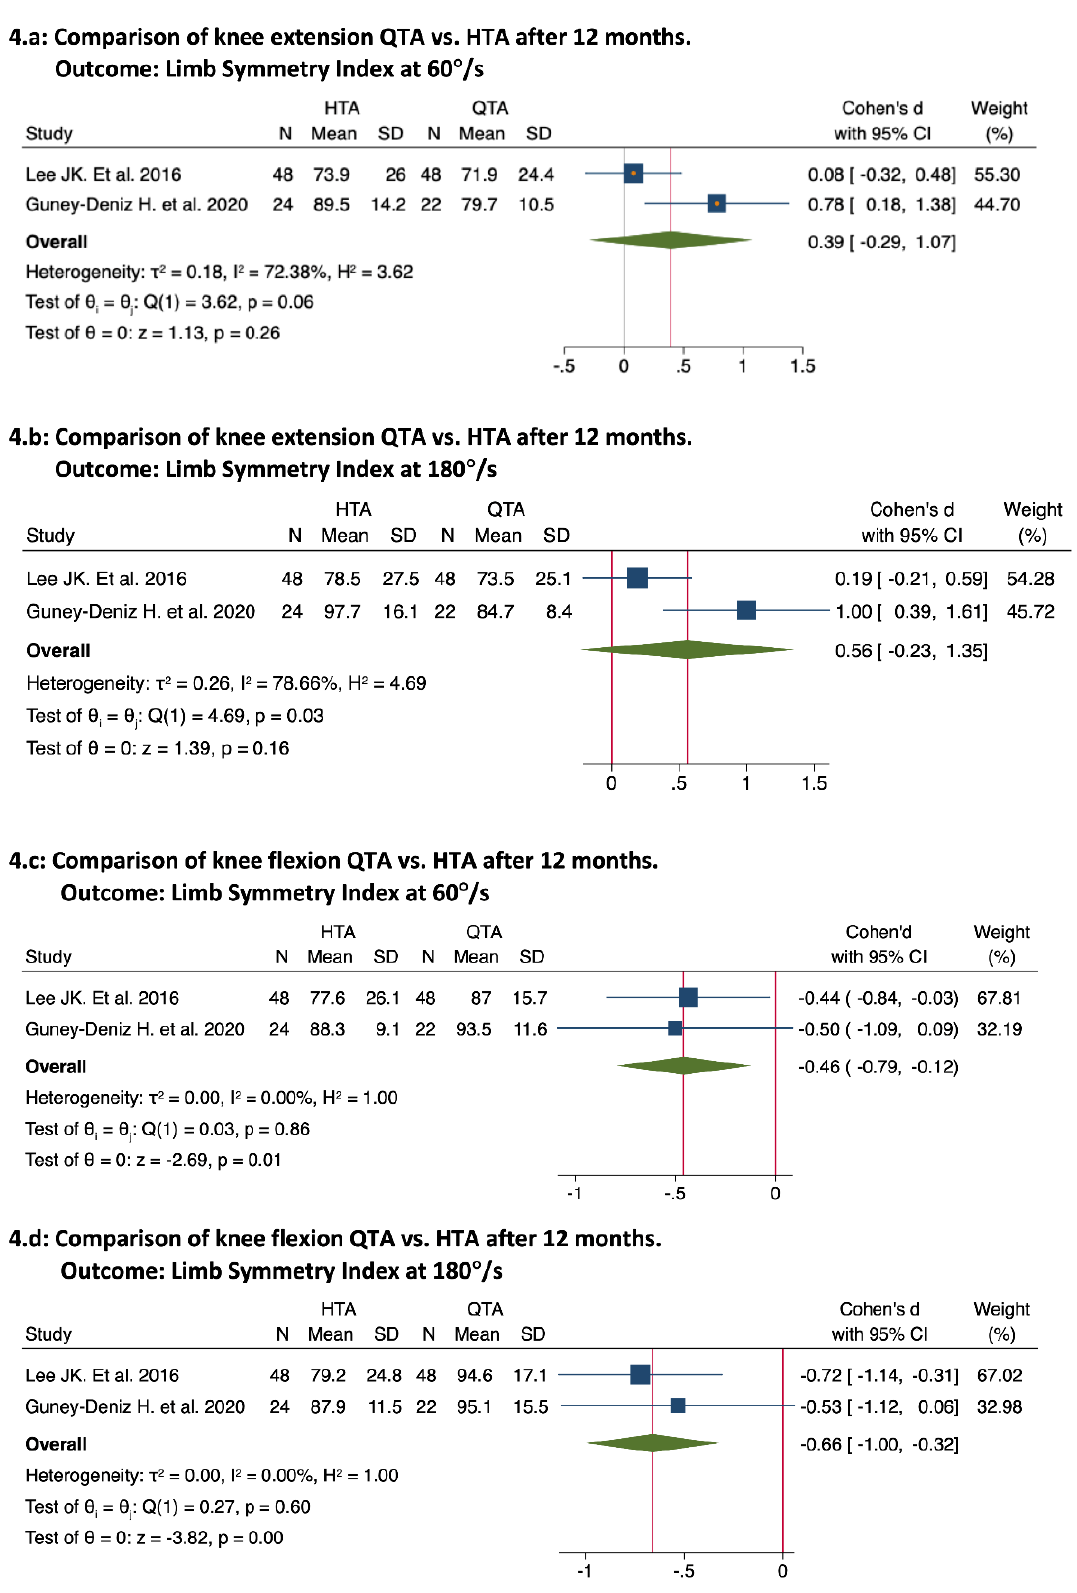
Figure 4. Forest plots for knee isokinetic strength test at 60°/s and 180°/s at 12 months [15,45].